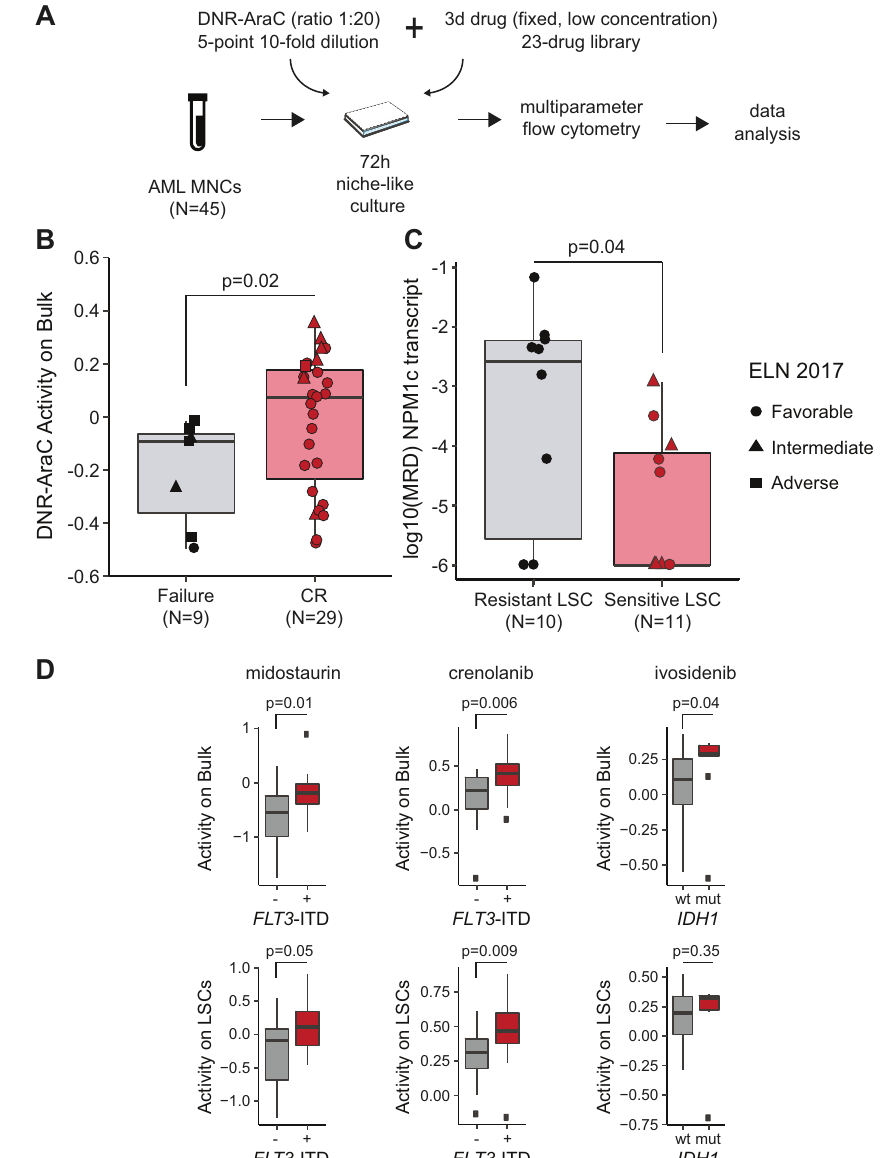
Fig. 5 Validation of the niche-like multiparametric drug screening platform. A Ex vivo drug screening of primary MNCs from 45 AML patients (Supplementary Table 1, including 37 with NPM1 mutations) with a 5-point, 10-fold DNR-AraC serial dilution in fi xed concentration ratio (1:20) with or without fi xed, low concentrations of each of 23 drugs (Supplementary Tables 3, 4). B DNR-AraC combination activity on the leukemic bulk in patients achieving CR ( N = 29) or induction failure ( N = 9) after an anthracycline-cytarabine induction course. Mann – Whitney test. Circles, triangles, and squares indicate individual data of samples with favorable, intermediate, and adverse genetic risk according to ELN 2017 classi fi cation [60]. Details on patient information and gene mutations are reported in Supplementary Tables 1, 2. C Log-transformed MRD on NPM1 transcripts in 21 NPM1 -mutated AML in CR, according to DNR-AraC ex vivo activity on LSC relative to lymphocytes (sensitive LSCs: activity on LSCs >activity on lymphocytes, N = 11; resistant LSCs: activity on LSCs ≤ activity on lymphocytes, N = 10). Mann – Whitney test. E Activity of the indicated drug on the bulk population (top panel) or the LSC population (bottom panel) according to the presence ( n = 16) or absence of FLT3 -ITD ( n = 29) or the IDH1 status (wildtype [wt] n = 36 or mutated [mut] n = 9). P values from Mann – Whitney